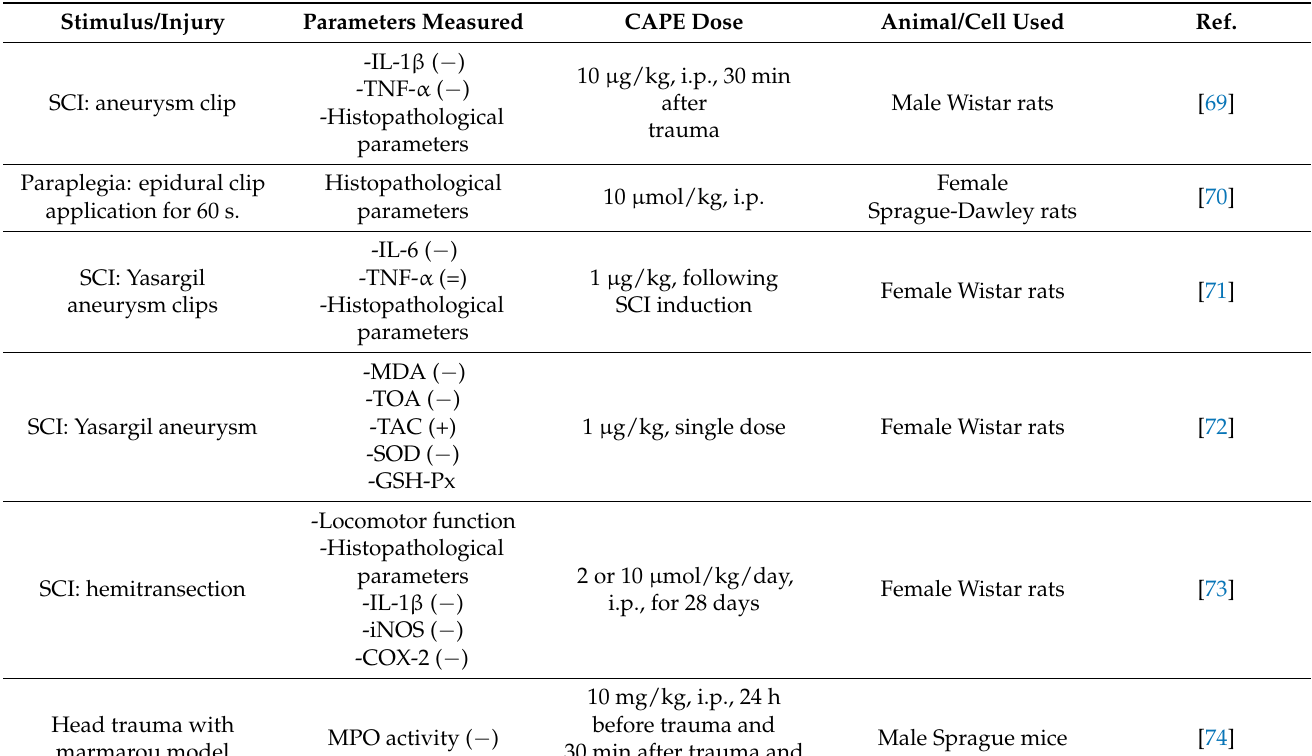
Table 4. Protective effects of CAPE against injury. Where applicable, the effect of CAPE on the parameters measured is reported between parentheses (+, − or